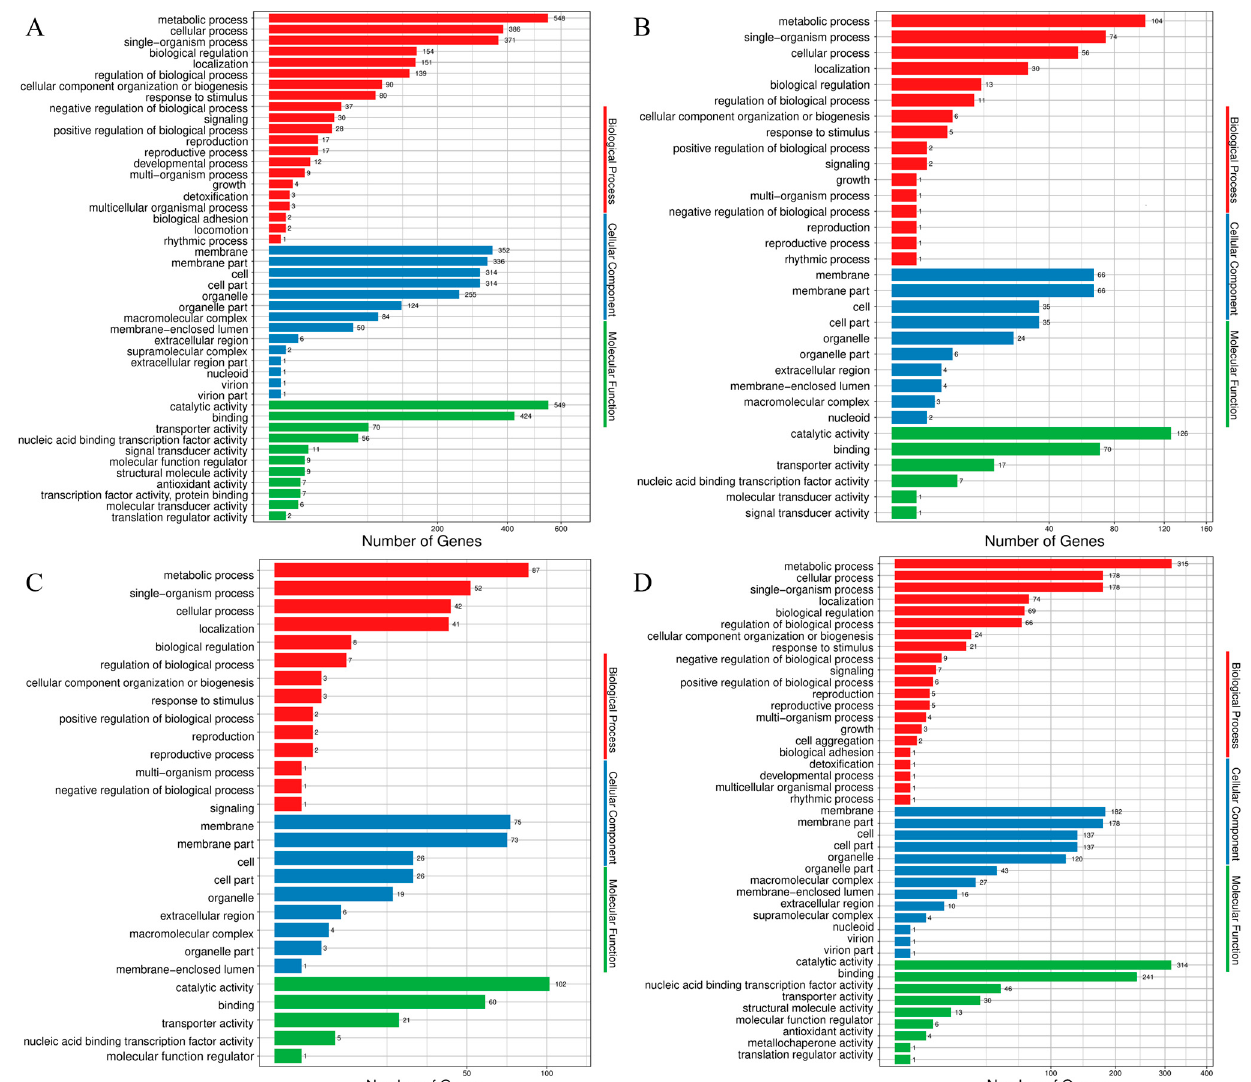
Figure 2. GO functional categories of all DEGs in T. harzianum T4 grown for ( A ) 12 h, ( B ) 24 h, ( C ) 48 h and ( D ) 72 h in the presence of BCCW.